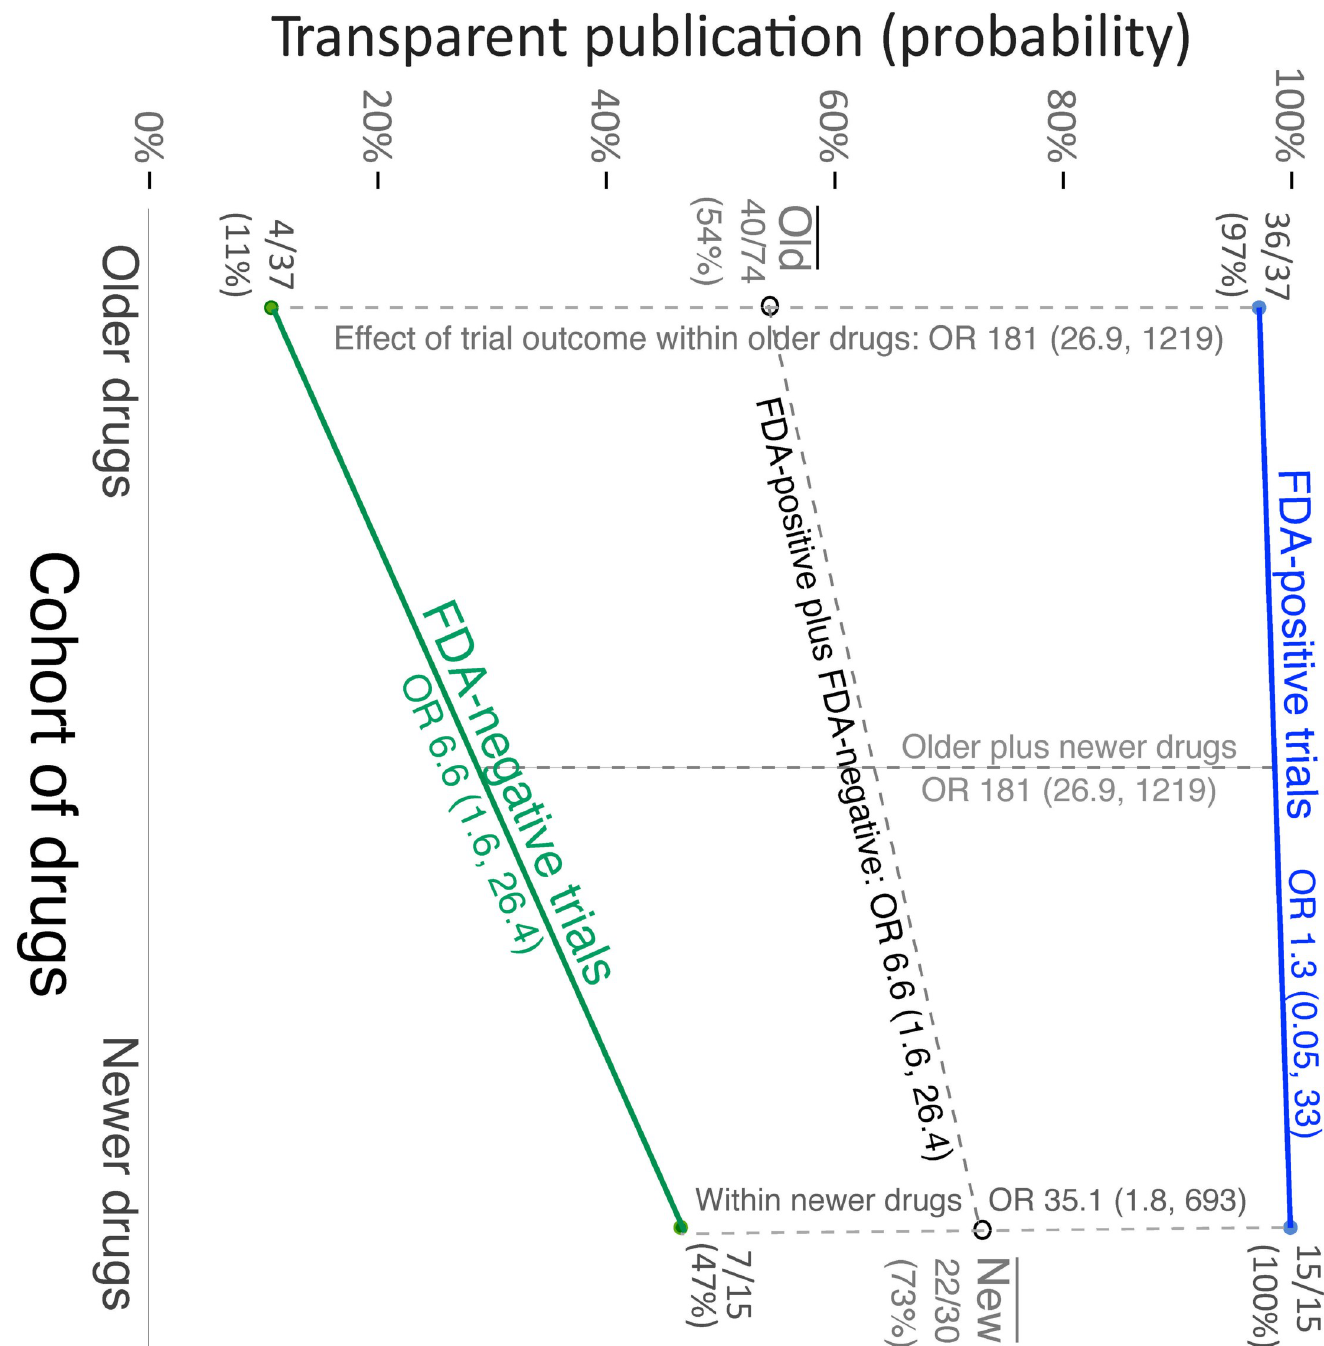
Fig 2. Interaction plot illustrating the effects of trial outcome and cohort (older vs. newer antidepressants) on transparent publication. For all trials regardless of outcome (dashed oblique line), the proportion of transparently reported trials increased from 54% (older drugs) to 73% (newer drugs). Within the subset of FDA- positive trials (blue line), transparent reporting, which was already nearly 100% for the older cohort, showed no further increase. By contrast, within FDA-negative trials (green line), transparent reporting increased from 11% to 47%. FDA, Food and Drug Administration.